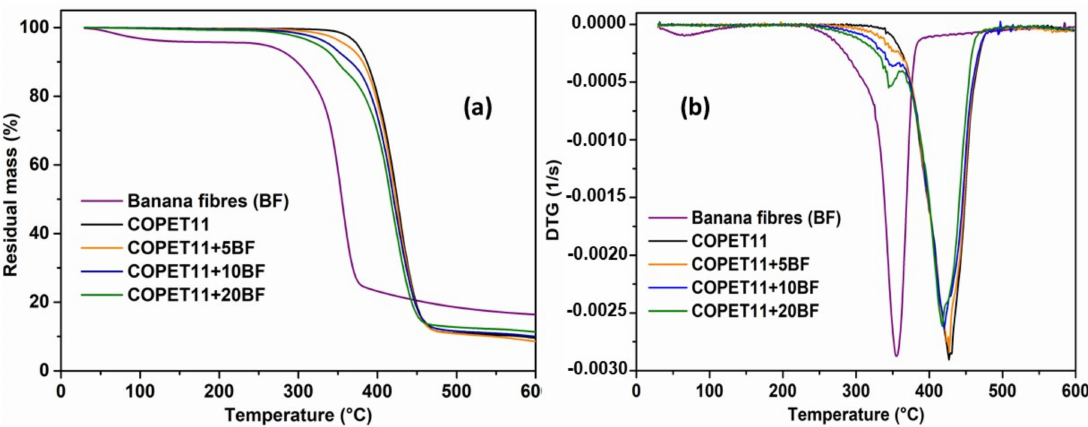
Figure 10. Thermal degradation of treated banana fibres, COPET11 and composites with different fibre contents, ( a ) TGA and ( b )